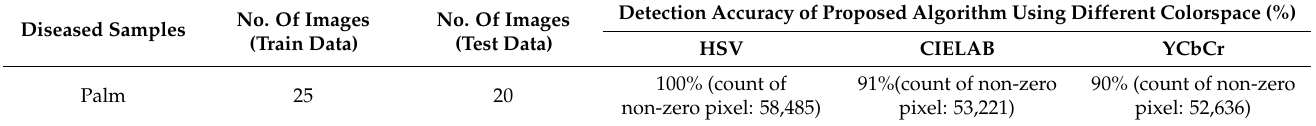
Table 9. Accuracy detection using different color